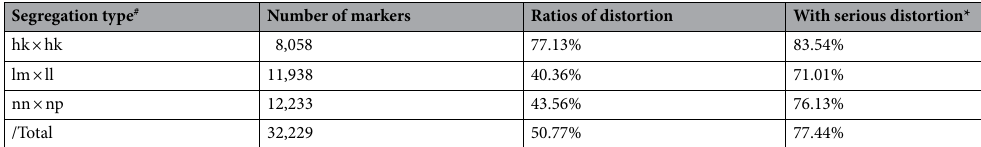
Table 1. Ratios of distorted markers in different types of segregating markers. # hk × hk represents that markers in both parents are heterozygous; lm × ll represents male parent is heterozygous while the female homozygous; nn × np represents female parent is heterozygous while the male homozygous *The ratio of seriously distorted markers (P < 0.001) to all distorted markers (P < 0.05).